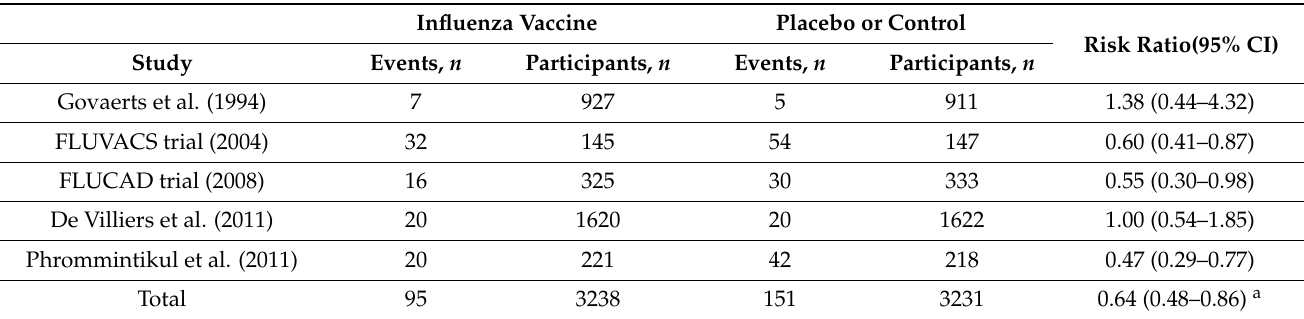
Table 2. Major adverse cardiovascular events associated with influenza vaccination vs. control in HF patients (meta-analysis of Udell et al.)